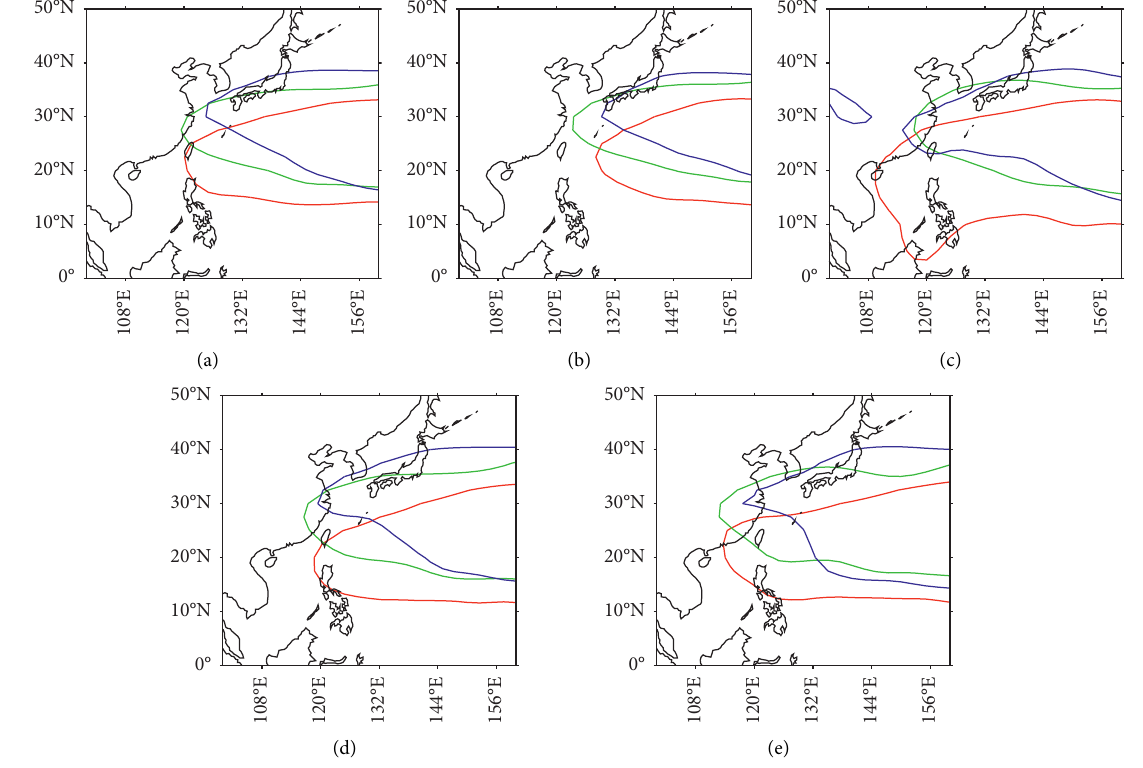
Figure 3: Monthly location of the Western Pacific Subtropical High (indicated by 5865gpm contour) for (a) climatology (averaged for the period of 1950–2017), (b) cool PDO in developing summers, (c) warm PDO in developing summers, (d) cool PDO in decaying summers, and (e) warm PDO in decaying summers. Red, green, and blue lines represent June, July, and August, respectively.